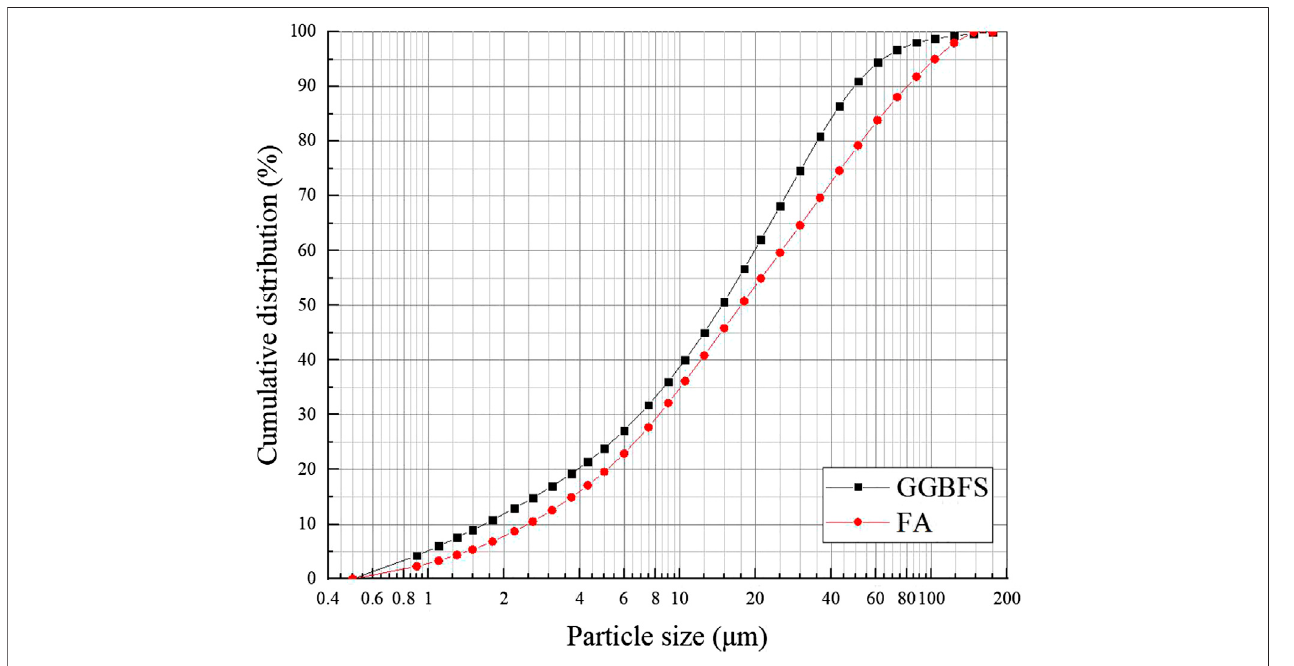
FIGURE 4 | Particle size distribution curves of GGBFS and FA.